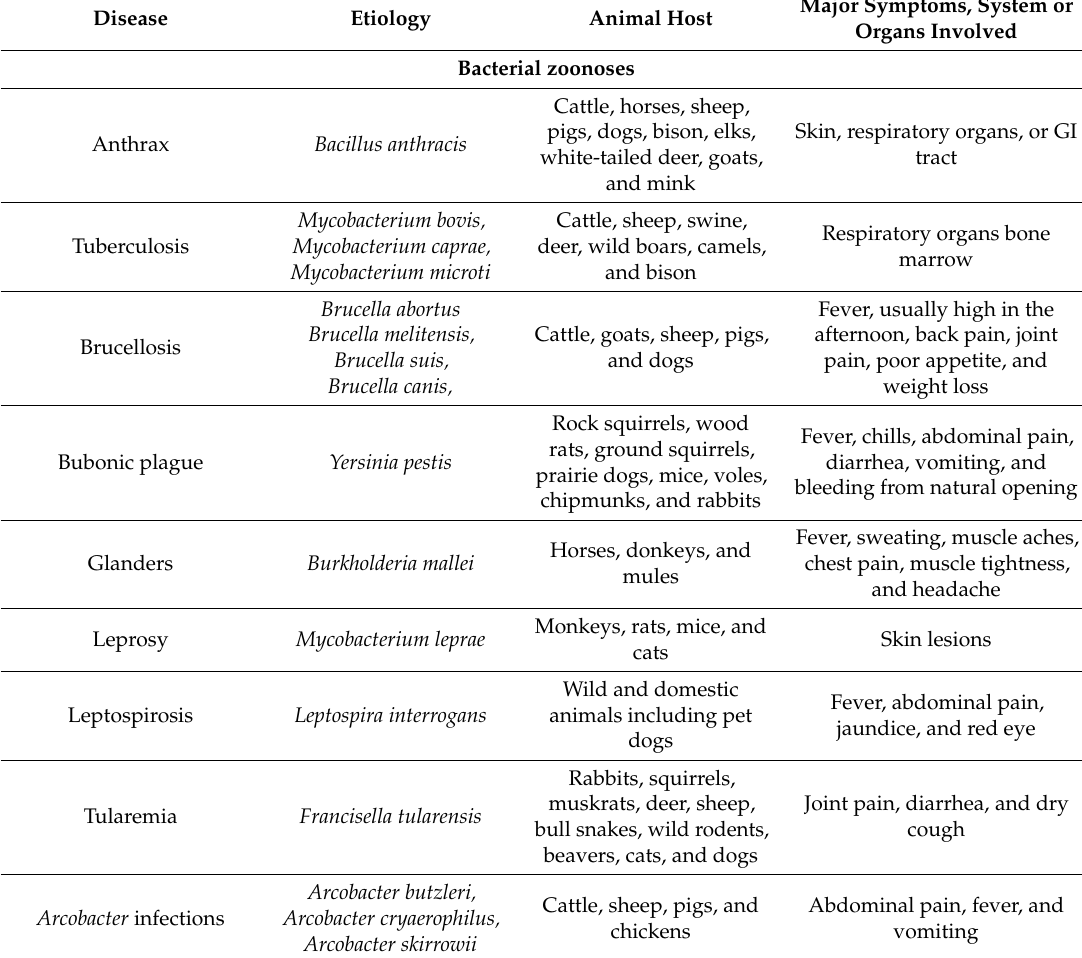
Table 1. Major Zoonotic Diseases, their etiological agents, hosts, and the major symptoms in humans.